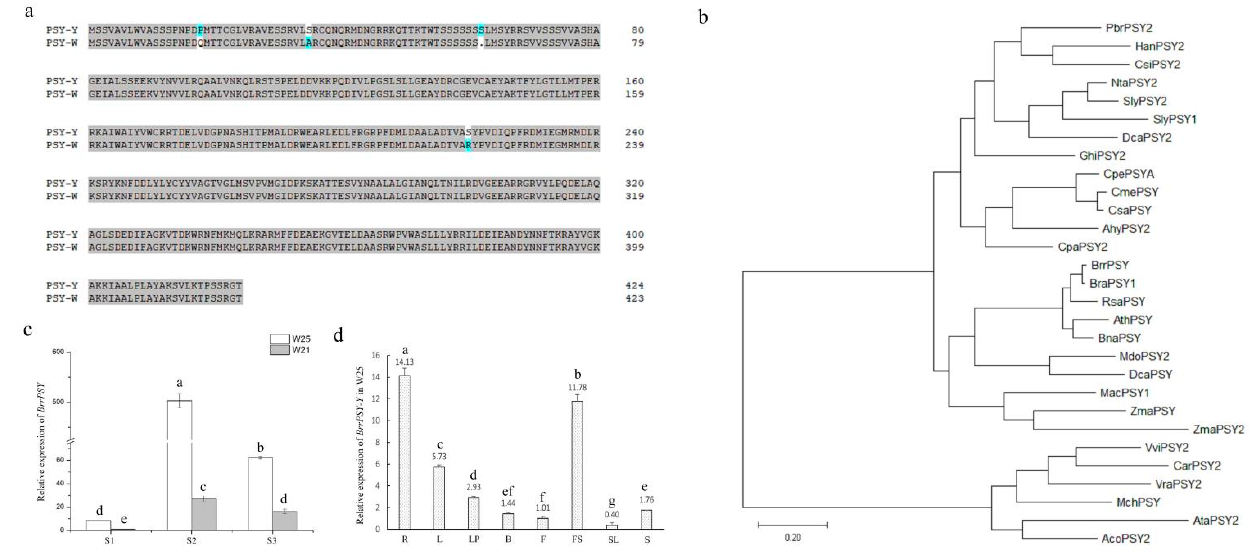
Figure 6. The analysis of candidate gene controlling the yellow-fleshed root coloration in turnip. ( a ) Sequence alignment of PSY-Y and PSY-W amino acid sequence. ( b ) Phylogenetic relationship between BrrPSY and other PSY genes. Vigna angularis (VraPSY2: XM_017575246.1); B . rapa subsp. pekinensis (BraPSY1: FJ227935.2); Nicotiana tabacum (NtaPSY2: NM_001325140.1); Ananas